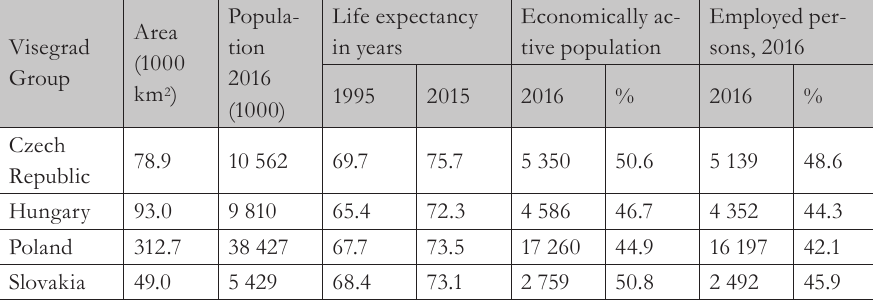
Tab. 2 – Selected indicators – area and population in the Visegrad countries. Source: Statistical Office Poland, 2018, www.stat.gov.pl (access: 03.2018)